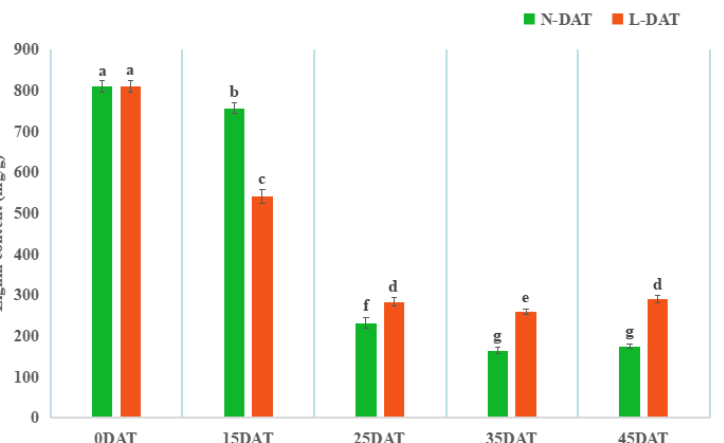
Figure 4. Total lignin content in ‘Xiao Baojian’ (XBJ) in different treatments. Error bars represent the SE ( n = 3). Values with the same letter were not significantly different at p < 0.05. N-DAT represents days after normal treatment, and L-DAT represents days after low-temperature treatment.